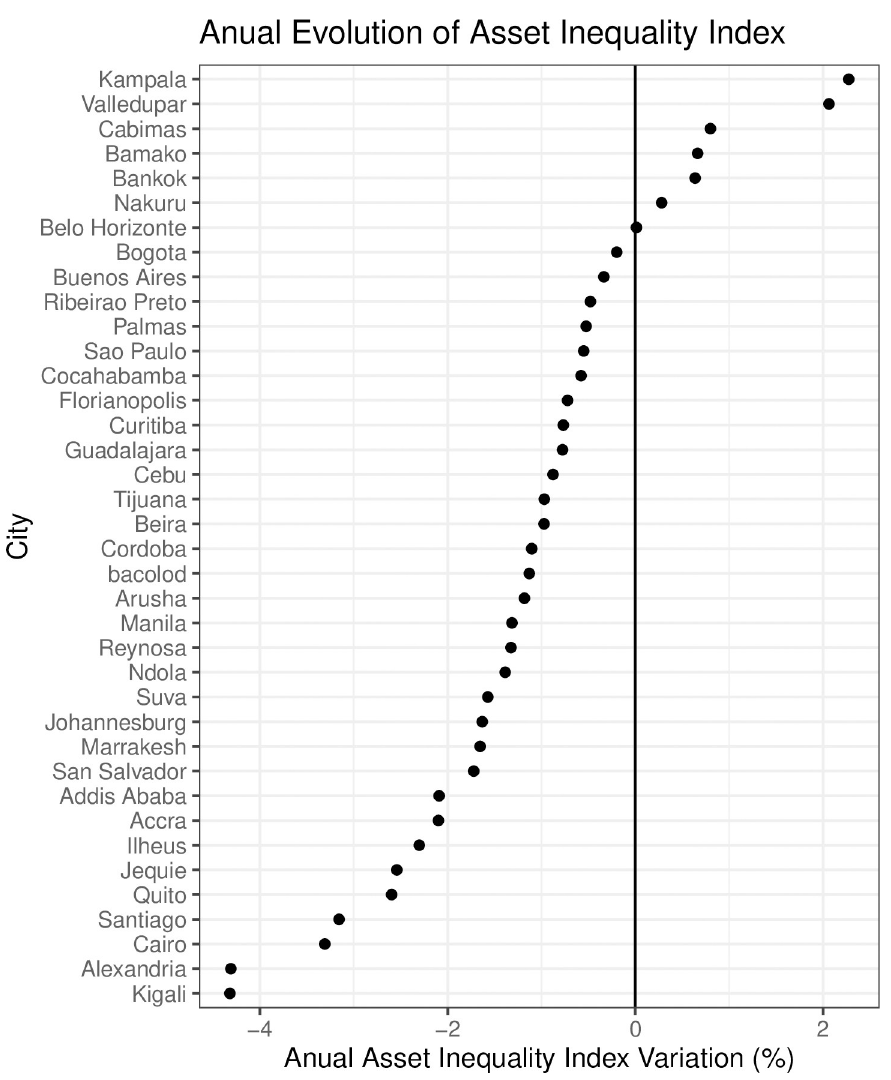
Fig 6. Annual variation of asset Inequality Index by